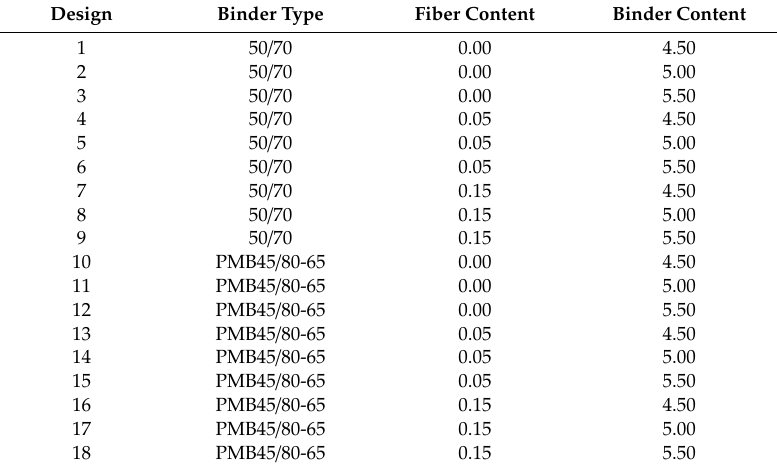
Table 2. Full factorial design with Taguchi orthogonal array